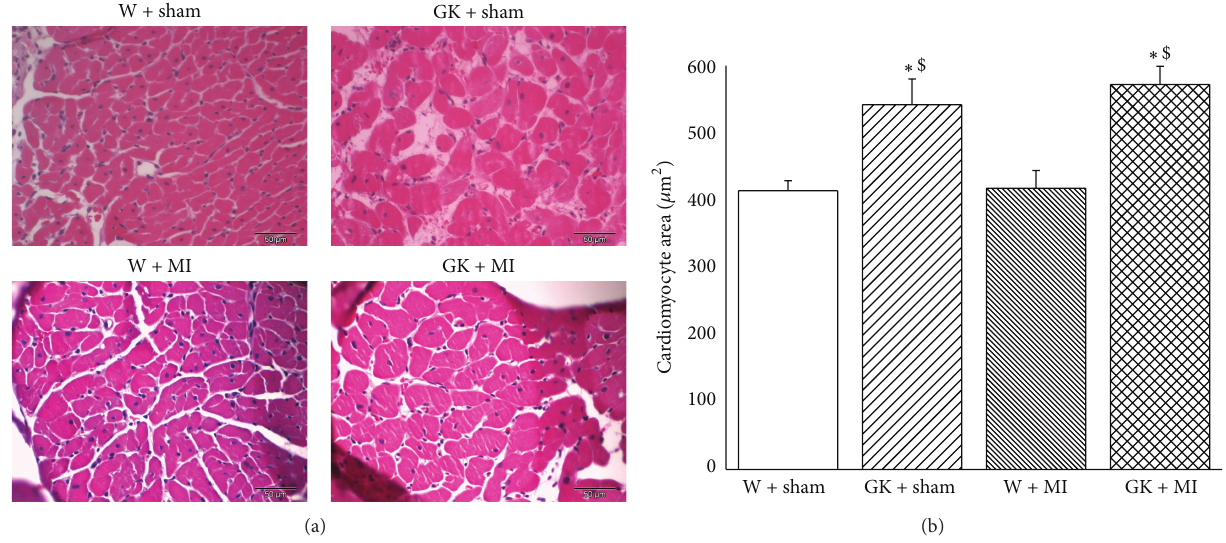
Figure 1: Histological analysis (hematoxylin and eosin staining). (a) Hematoxylin and eosin staining micrographs of transverse sections of myocardium (magnification × 400, scale bar: 50 𝜇 m) and (b) quantitative analysis of cardiomyocyte cross-sectional area using measurements of ∼ 20 cardiomyocytes in each group. Data is presented as mean ± SEM. ∗ 𝑃 < 0.05 versus W; GK; $ 𝑃 < 0.05 versus W + MI. MI indicates myocardial infarction; GK: Goto-Kakizaki; W: Wistar.